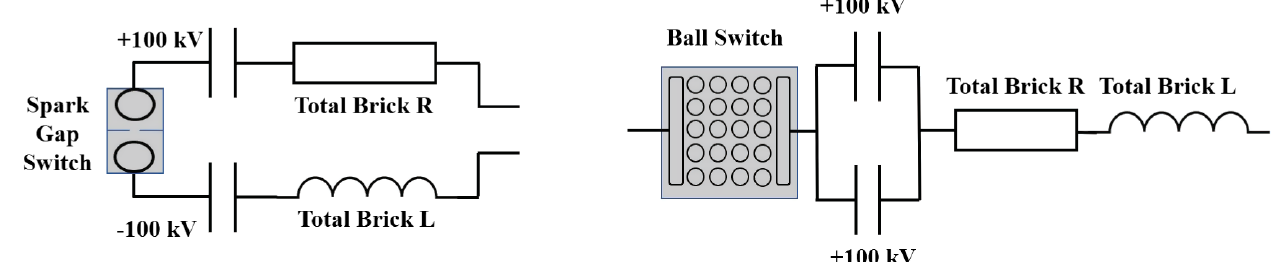
FIG. 3. The standard (left) versus dry (right) brick